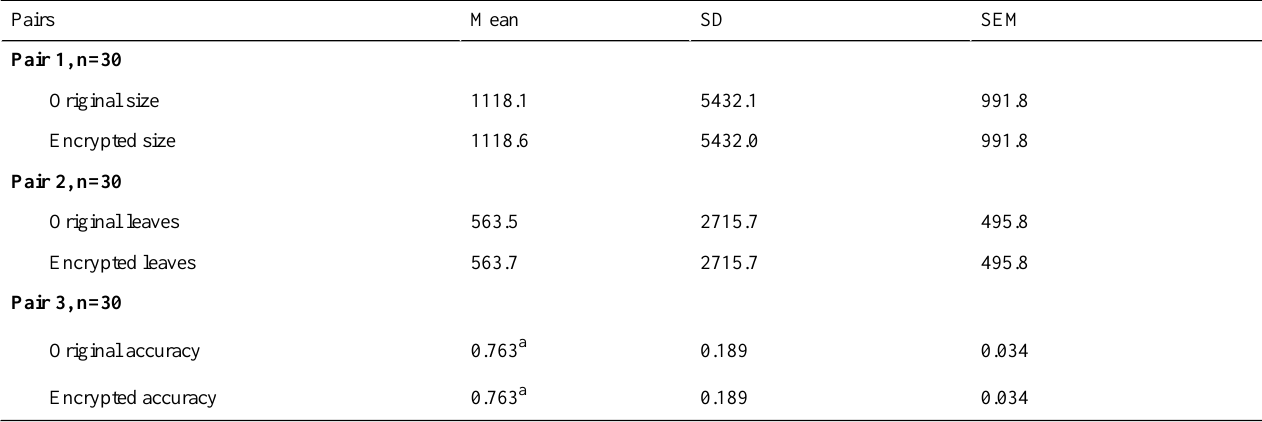
Table 2. Paired samples statistics.